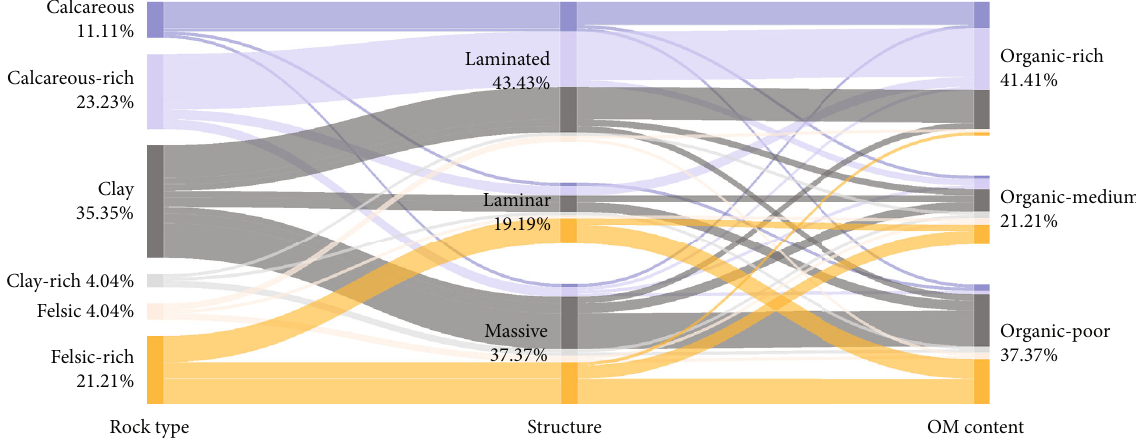
Figure 7: Correspondence between the rock types, bedding structure, and OM characteristics of the MS in the Es